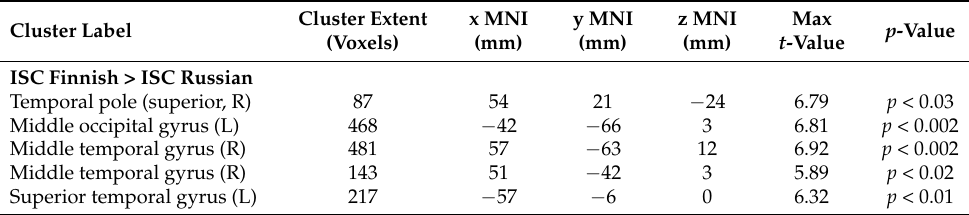
Table 3. Differences of ISC values between Finnish- and Russian-family-background participants. Cluster size, peak coordinates, the maximum t -values and p -values of the clusters obtained in the nonparametric two-sample t -test between the two participant groups (5000 cluster-wise permutations; cluster-defining threshold, uncorrected: p < 0.001; the 0.05 family-wise error-corrected cluster size: 62 voxels). The loci of ISC were labeled according to the Harvard–Oxford Cortical Structural Atlas [61] implemented in